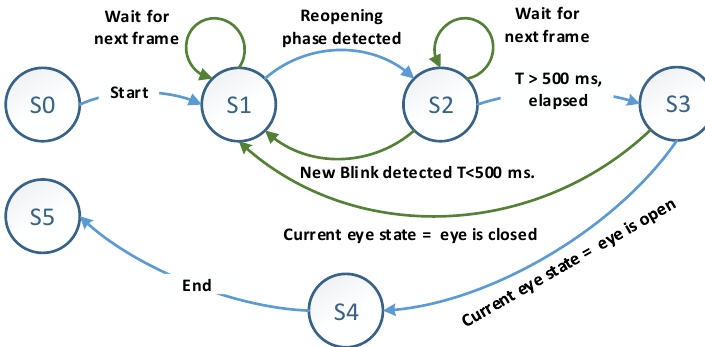
Figure 9. The finite state machine for open eye template image automatic selection.